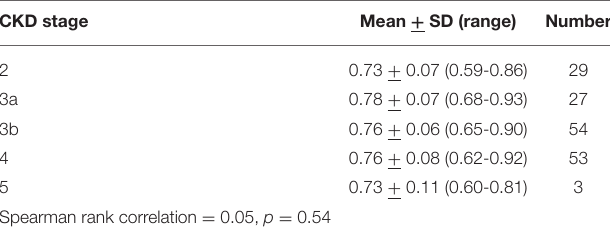
TABLE 3 | Mean + standard deviation (SD) of PET StatROI by CKD stage, The 90 +